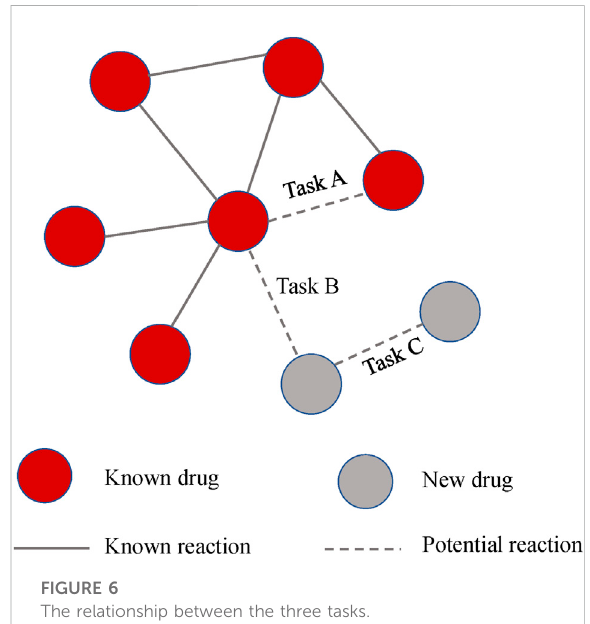
FIGURE 6 The relationship between the three tasks.